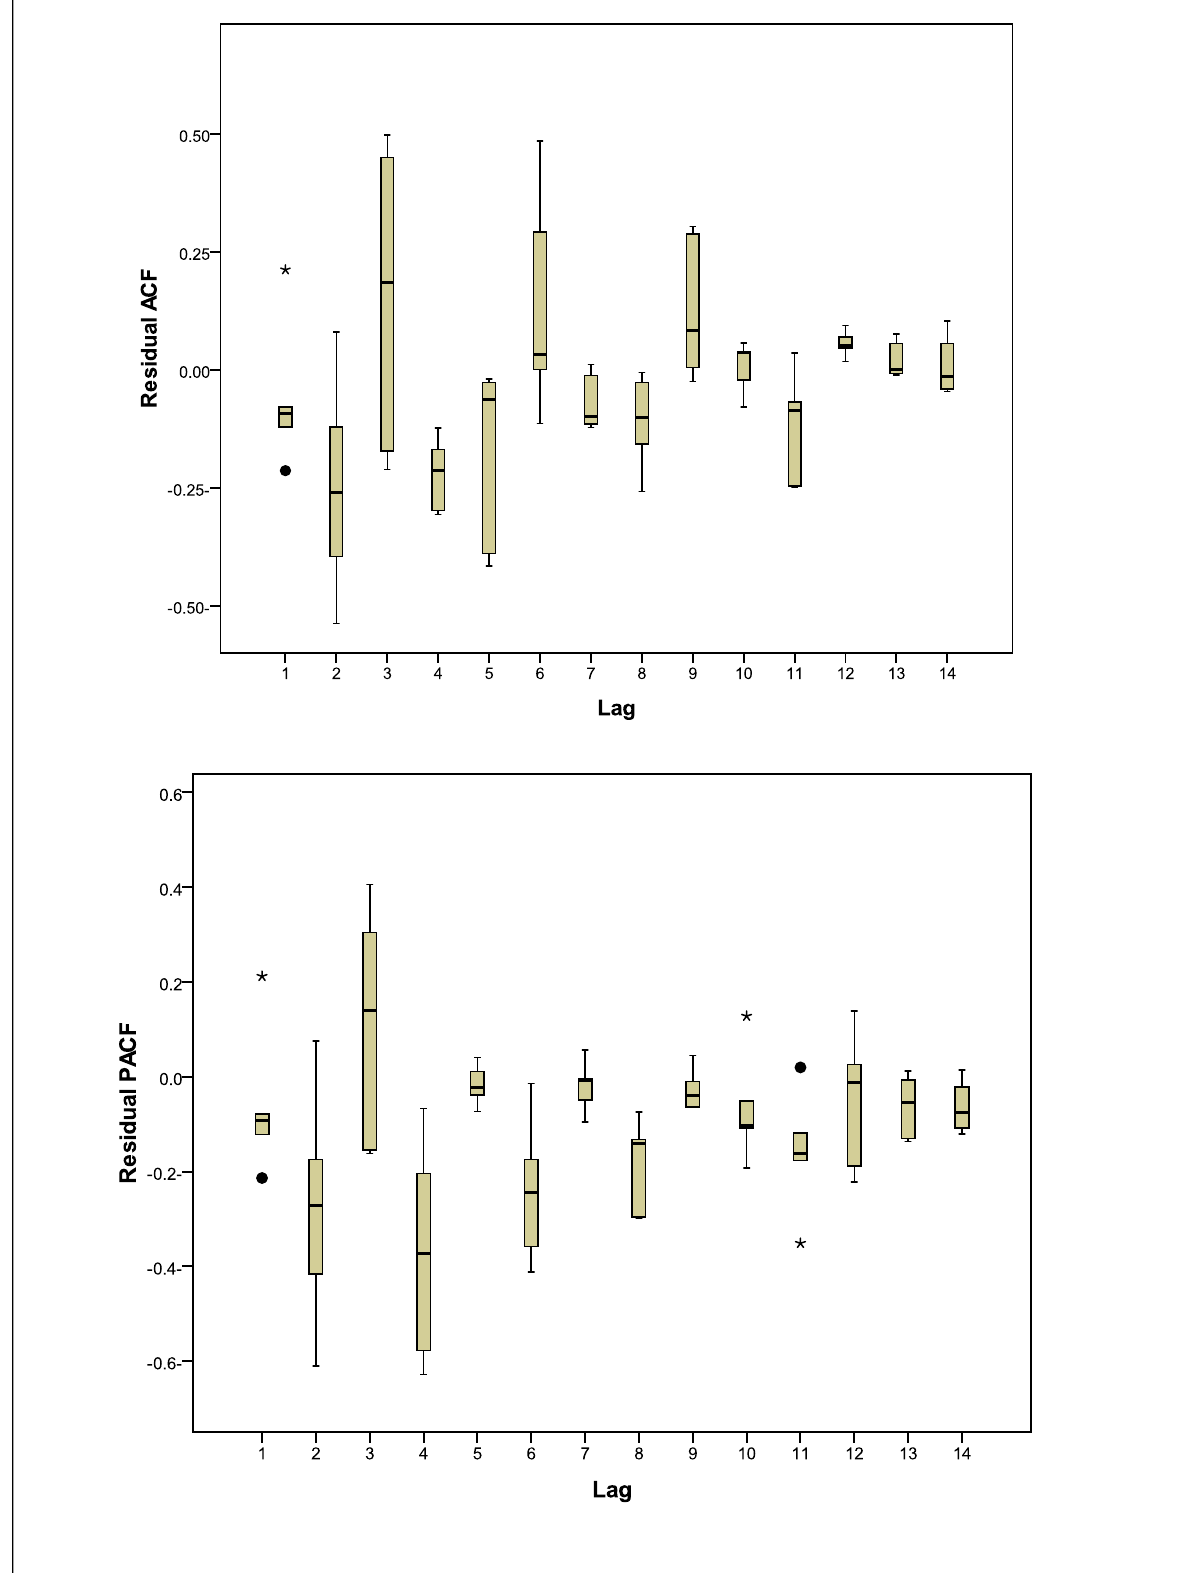
Figure 3: The residual autocorrelation function (ACF), and residual partial autocorrelation function plot (PACF) of the residual series between the forecasted series and the real (differential) series of time course post injection of vitamin B12 (0, 6, 12, 18 and 24 h) into adult Sitophilus